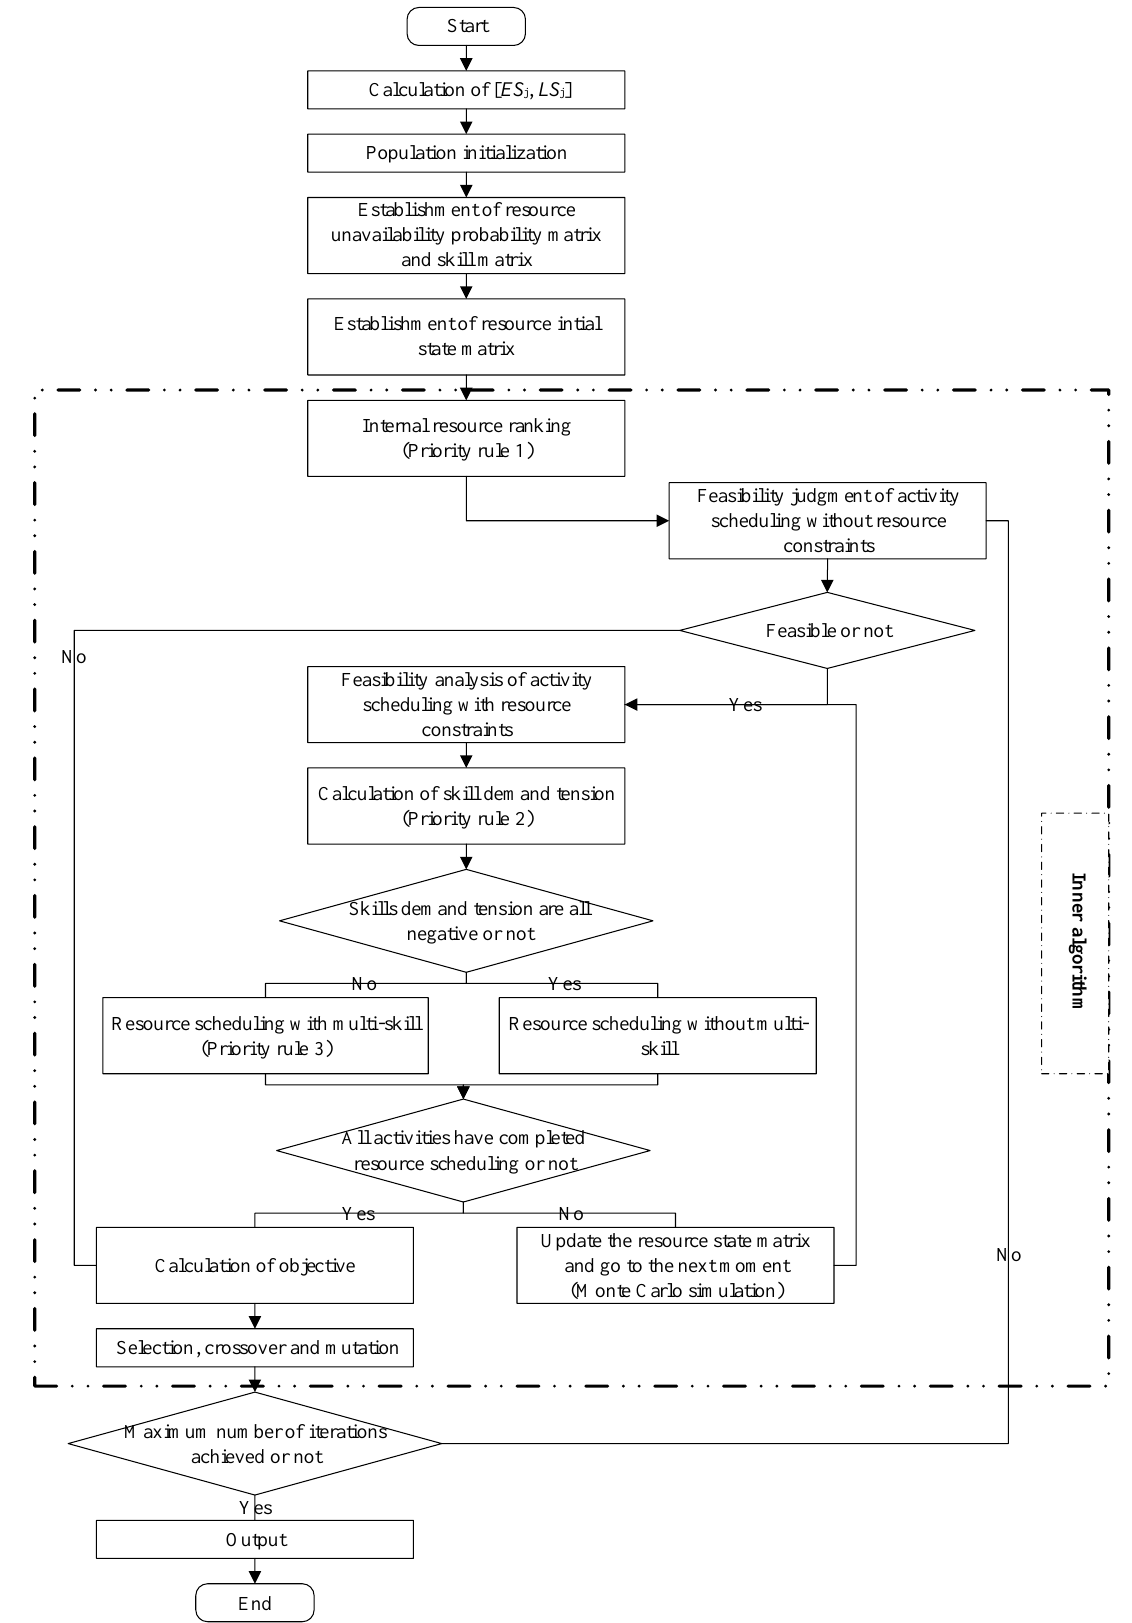
Figure 1. Flowchart of the GA-PR.